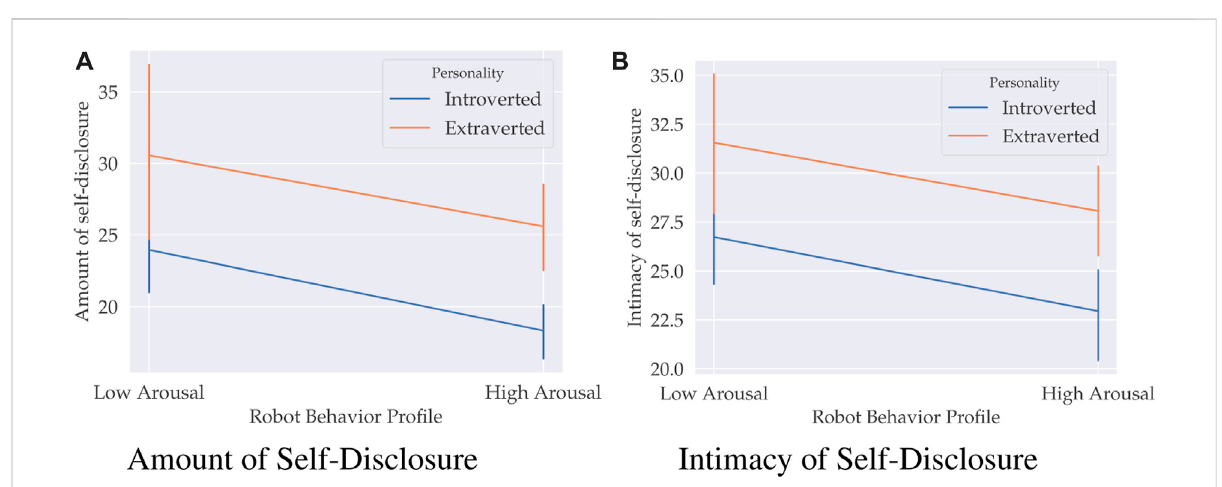
FIGURE 6 Meanself-disclosurescores(amountin( (A) andintimacyin (B) )forhighandlowrobotarousalbehaviorpro fi leandextravertsandintrovertswith 95% con fi dence